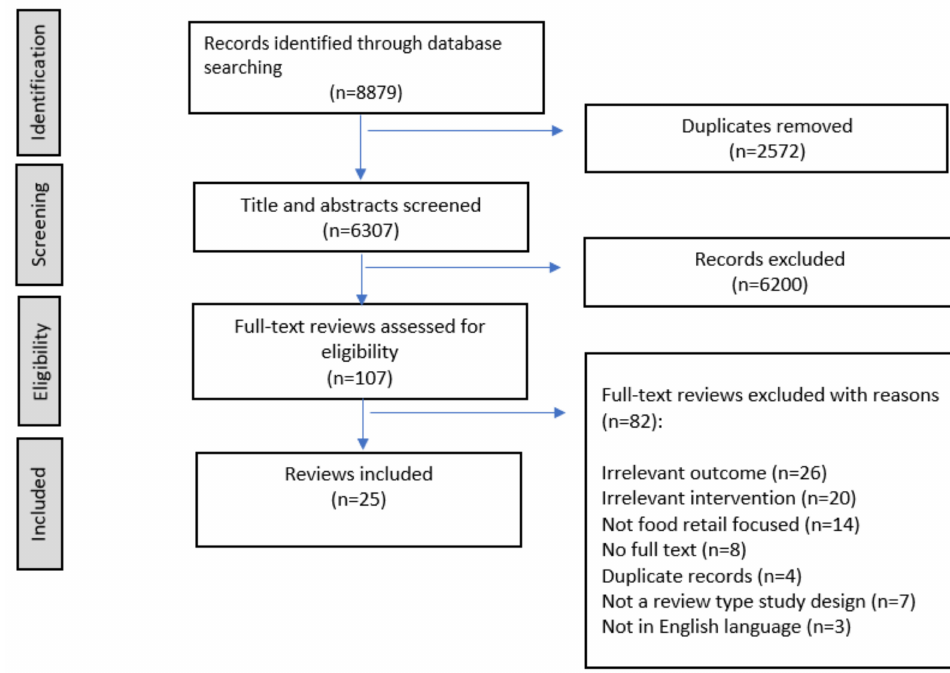
Figure 1. PRISMA flowchart. Table 2. Characteristics and findings of the included reviews ( n =